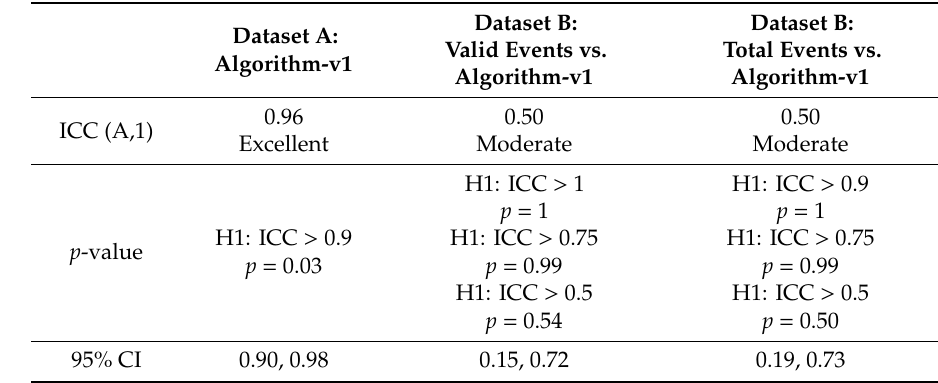
Table 2. Inter-rater reliability (IRR) results for Algorithm-v1. It performed very well on data from young healthy subjects (second column). However, performance dramatically dropped on data from older adults (third column). Not omitting unsuccessful sit-to-stand transitions did not improve Algorithm-v1 performance on data from older people (fourth column). ICC—intra-class correlation coe ffi cient; CI—confidence